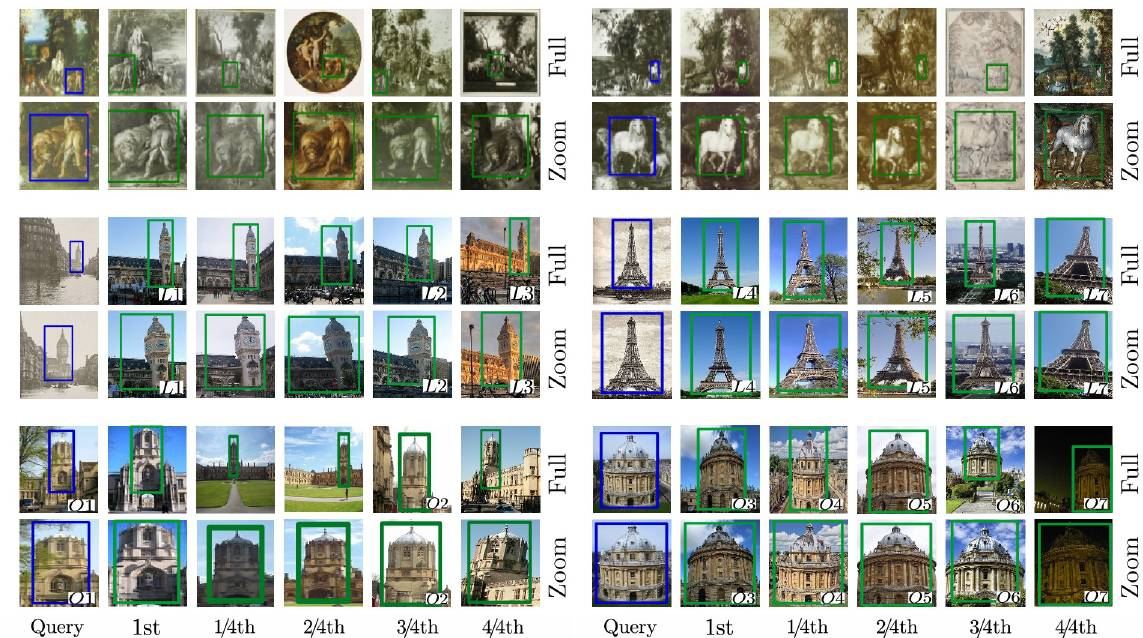
Fig 12. Retrieval examples on Brueghel, LTLL and Oxford5K. Rows 1–2, 3–4 and 5–6 show search examples of the Brueghel, LTLL and Oxford5K dataset, respectively. To allow for a better comparison, the first rows show retrievals in the full image (Full) and the second rows display enlarged versions (Zoom). Queries are shown in blue on the left and retrievals on the right. We highlight correct and incorrect retrievals with green and red bounding boxes, respectively. For a better overview, we draw only the first and four additional search results with equidistant ranks. We set the distance between between ranks to the number of ground truth matches of the query divided by four. Due to copyright issues, we replaced several images. We made sure that replacements are as similar as possible to the originals. The original figure is also available on our project website. Image (L4), (L7), (O1), (O2), (O4), (O6) and (O7) are slight modifications of [82–88]licensed under CC BY 2.0. Image (L1), (L2), (L3), (L5), (L6), (O3) and (O5) are slight modifications of [89–95] licensed under CC BY 3.0. The remaining image material is shared by Yale University Art Gallery [96] or Wikimedia Commons [5] either as public domain or under a CC0 license.